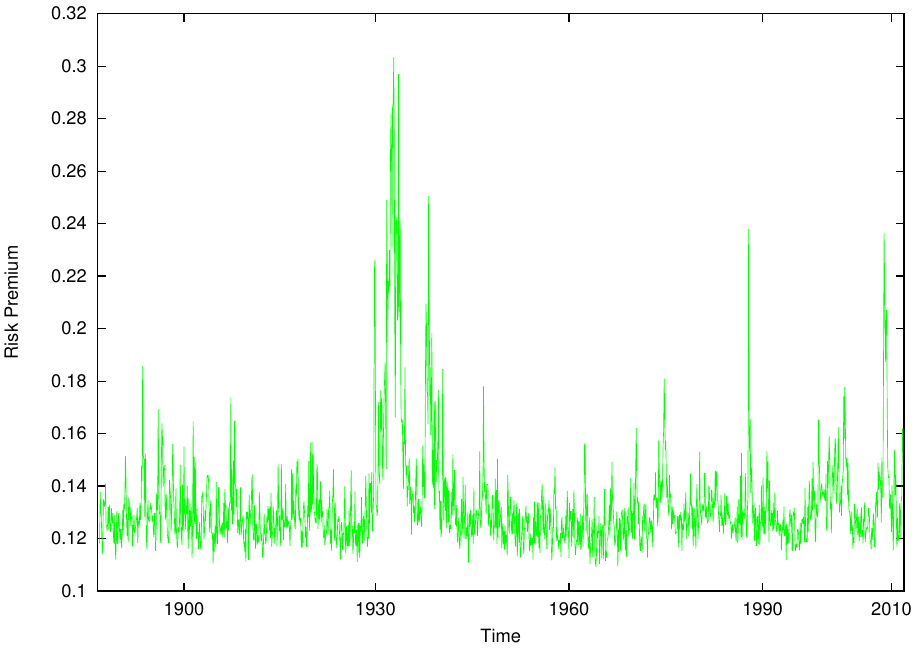
Figure 8. Time series of equity risk premium.